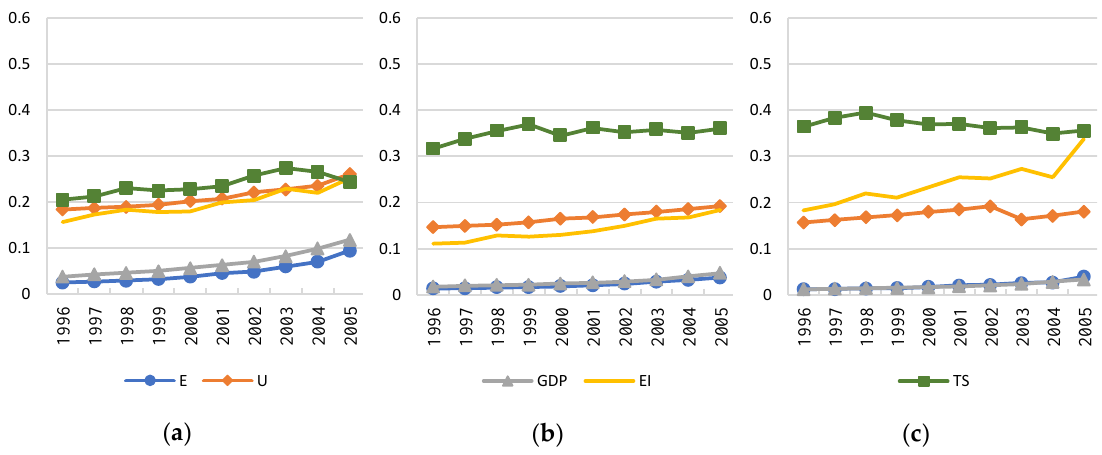
Figure 3. Trends of the variables in three regions (1996–2005). ( a ) Eastern Region; ( b ) Central Region; ( c ) Western Region.